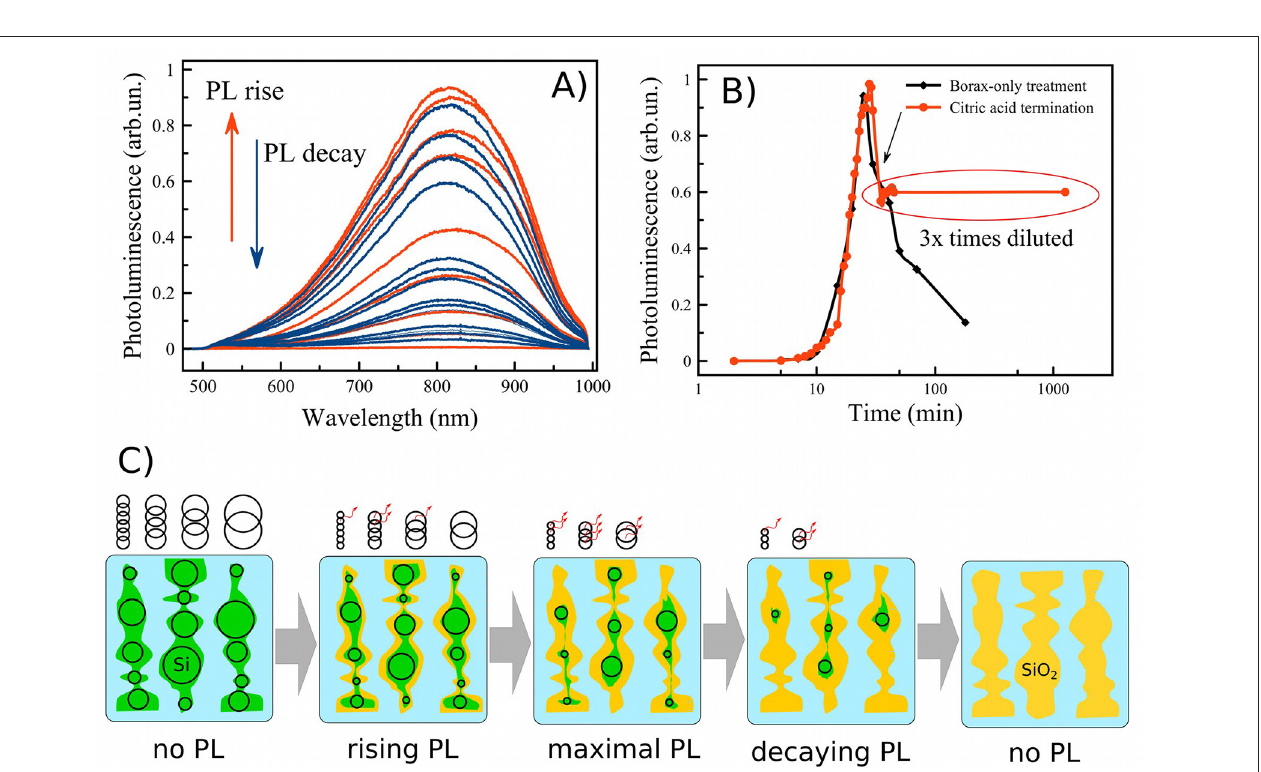
FIGURE 3 | Family of PL spectra of porous silicon nanoparticles obtained during aqueous borax oxidation (A) ; evolution of the PL intensity (measured at the emission maximum) during borax oxidation without (black curve— B ) and with termination by citric acid (red curve— B ); schematic view of the oxidation process starting from as-prepared PSiNPs through maximal emissive state to complete oxidation in borax (C) . Green—Si skeleton, yellow—SiO 2 shell, black circles—silicon nanocrystals (nc-Si) indicating the size of the nanocrystals, some of which fit the quantum confinement criteria for efficient emission, indicated with the red